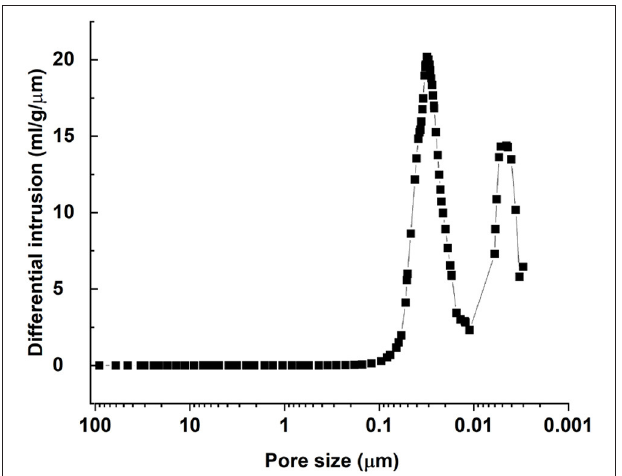
FIGURE 5 | Pore size distribution obtained from mercury intrusion experiments.